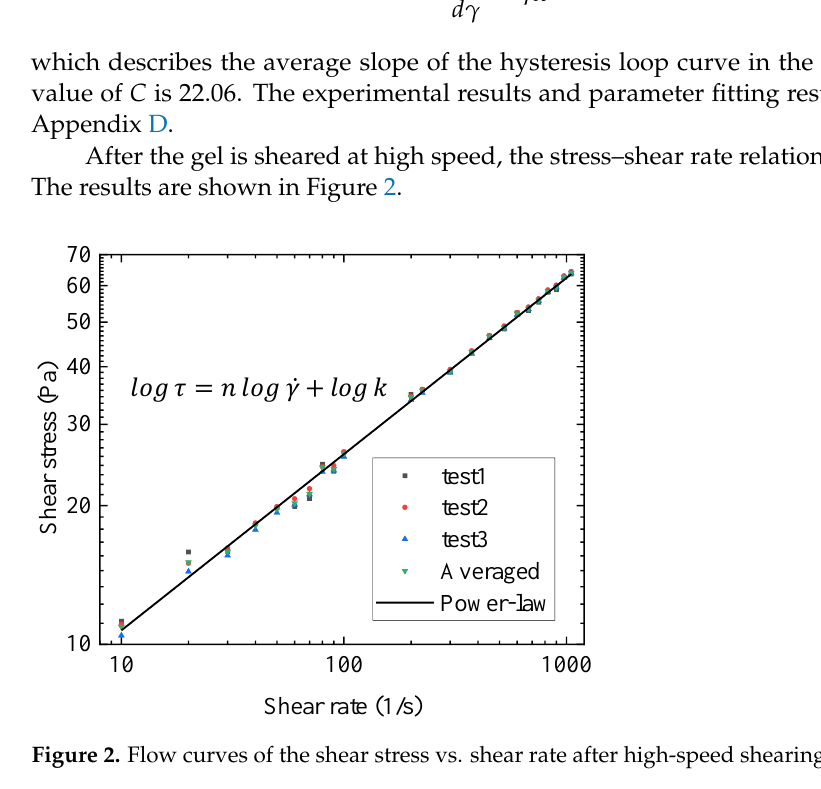
value of 𝐶 is 22.06. The experimental results and parameter fitting results are shown in which describes the average slope of the hysteresis loop curve in the initial stage. The Appendix D. value of C is 22.06. The experimental results and parameter fitting results are shown in Appendix D. Appendix D.